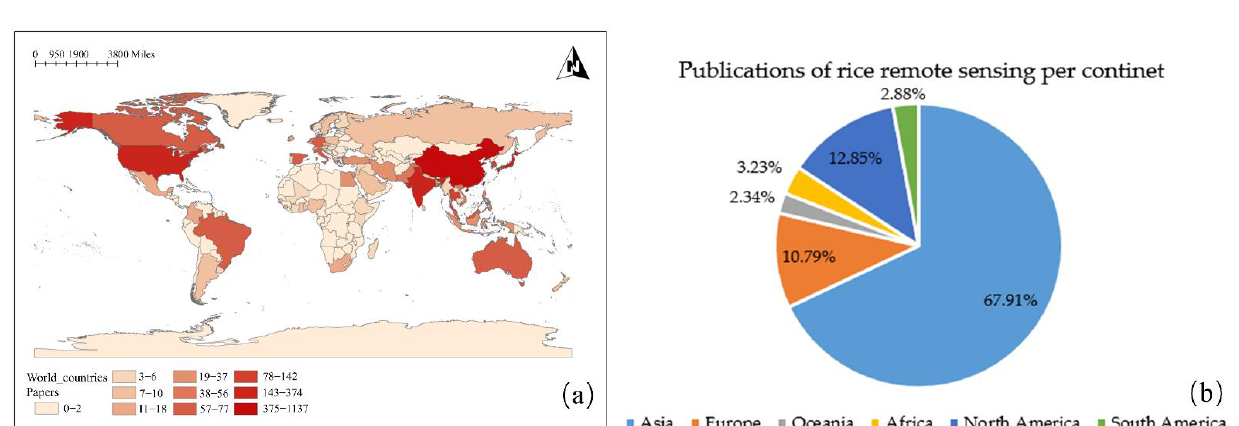
Figure 3. Visualization of the number of published documents by country ( a ) and by continent ( b ).